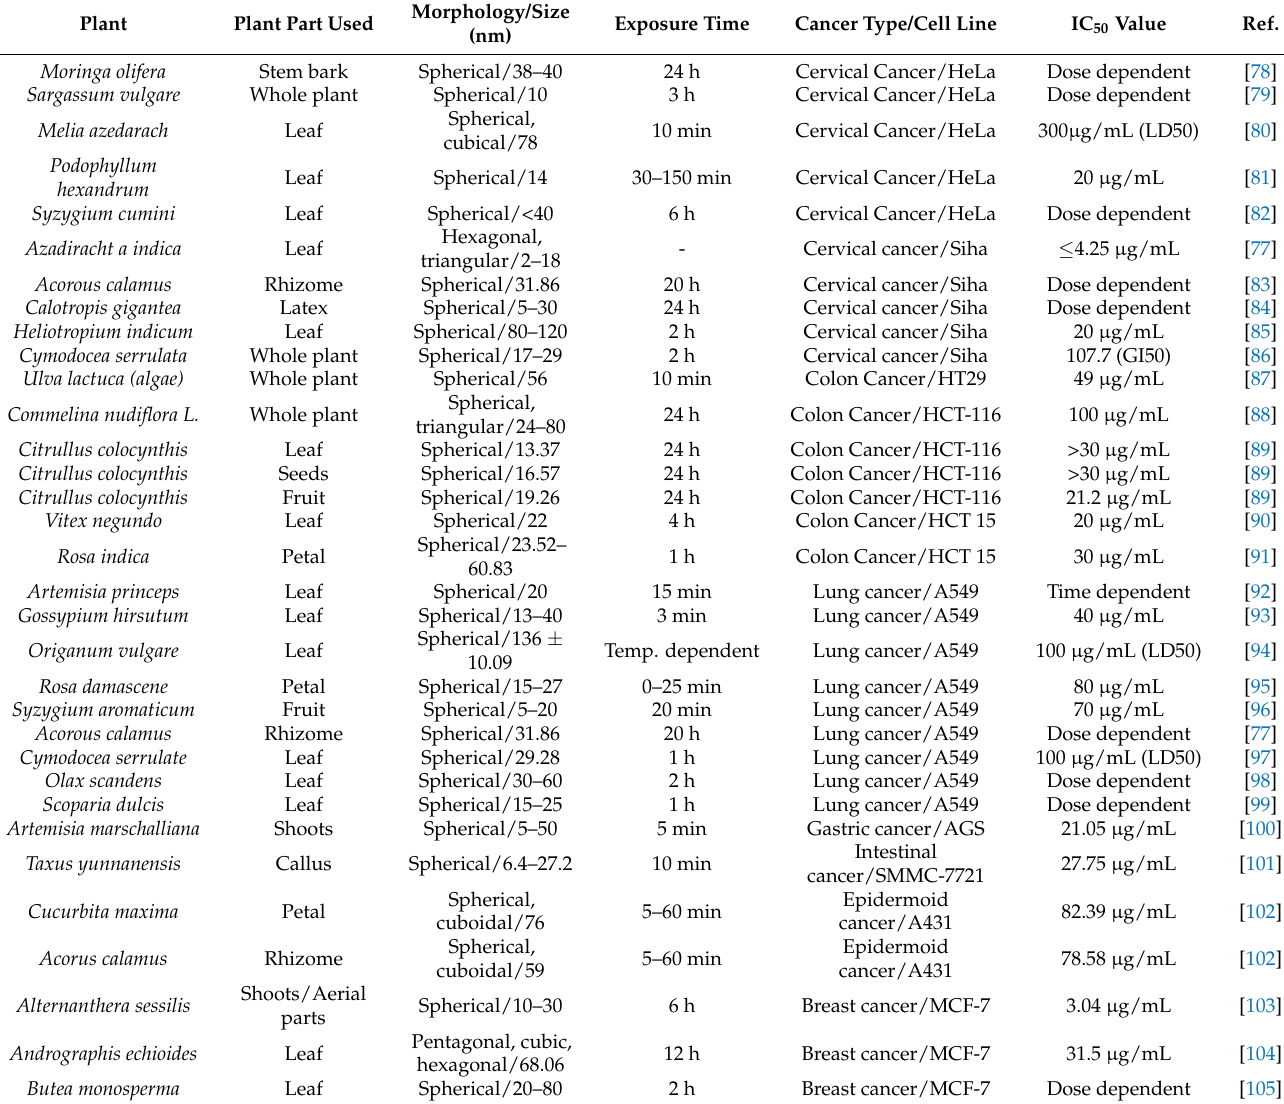
Table 1. List of studies exhibiting biosynthesized silver NPs and their anticancer